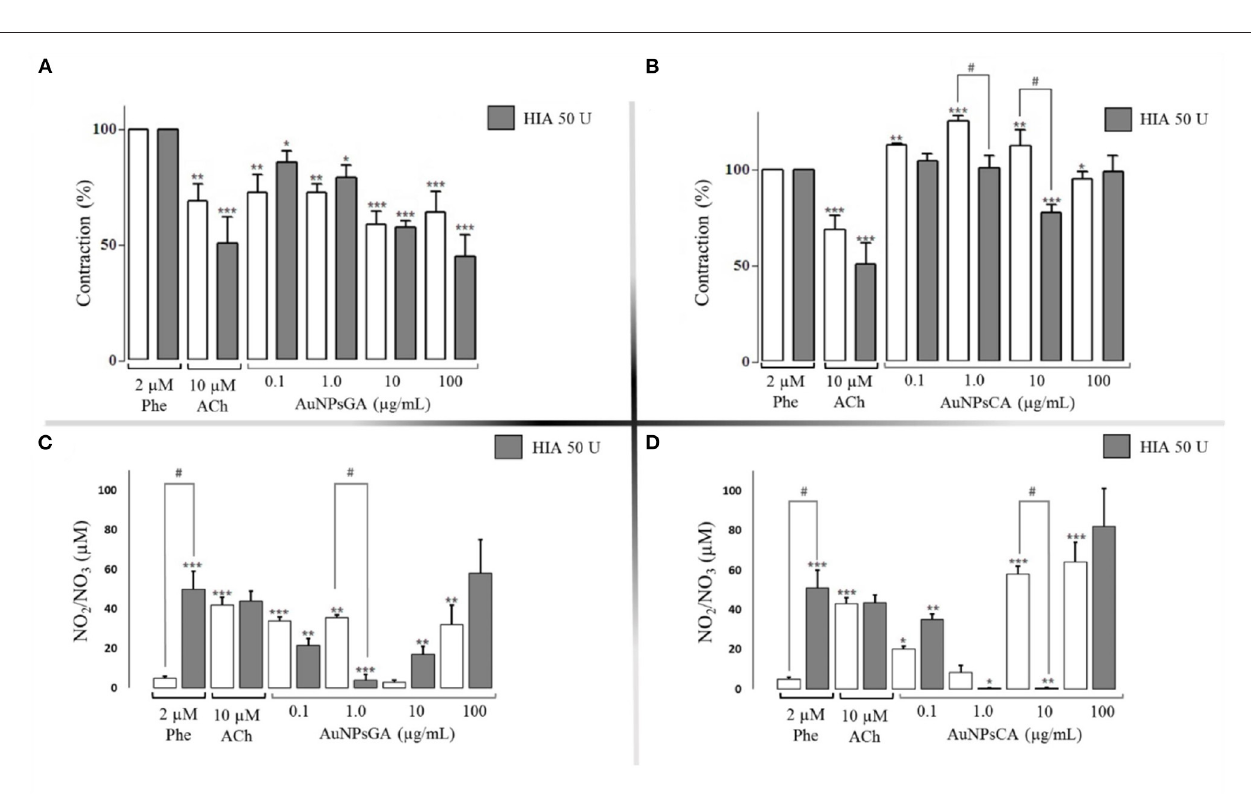
FIGURE 4 | Effects induced by AuNPsGA and AuNPsCA previously treatment with HIA 50U. Percentage of contraction induced by single concentrations of AuNPsGA (A) 0.1, 1.0, 10, and 100 µ g/mL, and (B) singles concentrations of AuNPsCA (A) 0.1, 1.0, 10, and 100 µ g/mL. Graphics A and B show aortic ring contraction with previous treatment with either 0U HIA (white bars) or 50U HIA (gray bars) on precontracted aortic rings with Phe 2 µ M. The contraction was calculated as the percentage of tension based on 100% contraction induced by Phe 2 µ M. Results are representative of three independent experiments. NO production, in the presence of AuNPsGA (C) and AuNPsCA (D) (0.1, 1, 10, and 100 µ g/mL), also with previous treatment with either 0U of HIA (white bars) or 50U HIA (gray bars). NO levels were determined by Griess method. Values are represented as mean ± SEM ( n = 3). * P < 0.05, ** P < 0.01 and *** P < 0.001 vs. control with Phe (white bars) or the control with Phe and 50U HIA (gray bars). # P < 0.001 differences between no presence of HIA 50U and presence of HIA